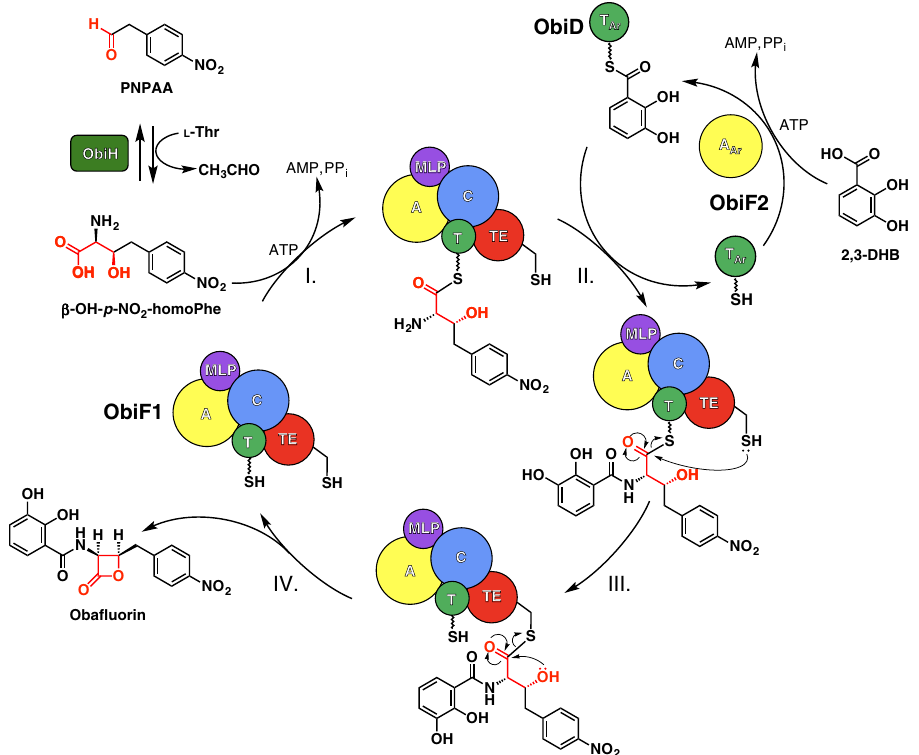
Fig. 1 Oba fl uorin biosynthetic pathway. The NRPS catalytic cycle begins with (I) activation and loading of (2 S ,3 R )- β -OH-p-NO 2 -homoPhe, generated by trans -aldol reaction of p-nitrophenylacetaldehyde (PNPAA) with a glycine enolate catalyzed by the L -Thr transaldolase ObiH, onto the ObiF1 PCP domain (T, green) by the ObiF1 adenylation domain (A, yellow). (II) Concurrently ObiF2 (A Ar , yellow) activates 2,3-dihydroxybenzoic acid (2,3-DHB) and loads it onto ObiD (T Ar , green). (III) Substrate-loaded ObiD then docks onto the ObiF C domain (C, blue), where the α -amino group of β -OH-p-NO 2 -homoPhe-T domain thioester is acylated by 2,3-DHB. (IV) Subsequent transthioesteri fi cation occurs between the substrate-loaded ObiF PCP domain and TE domain (TE, red) followed by TE domain catalyzed β -lactone formation and oba fl uorin release. The C-terminal MLP domain (purple) is highlighted to show interactions with the C and A domains of